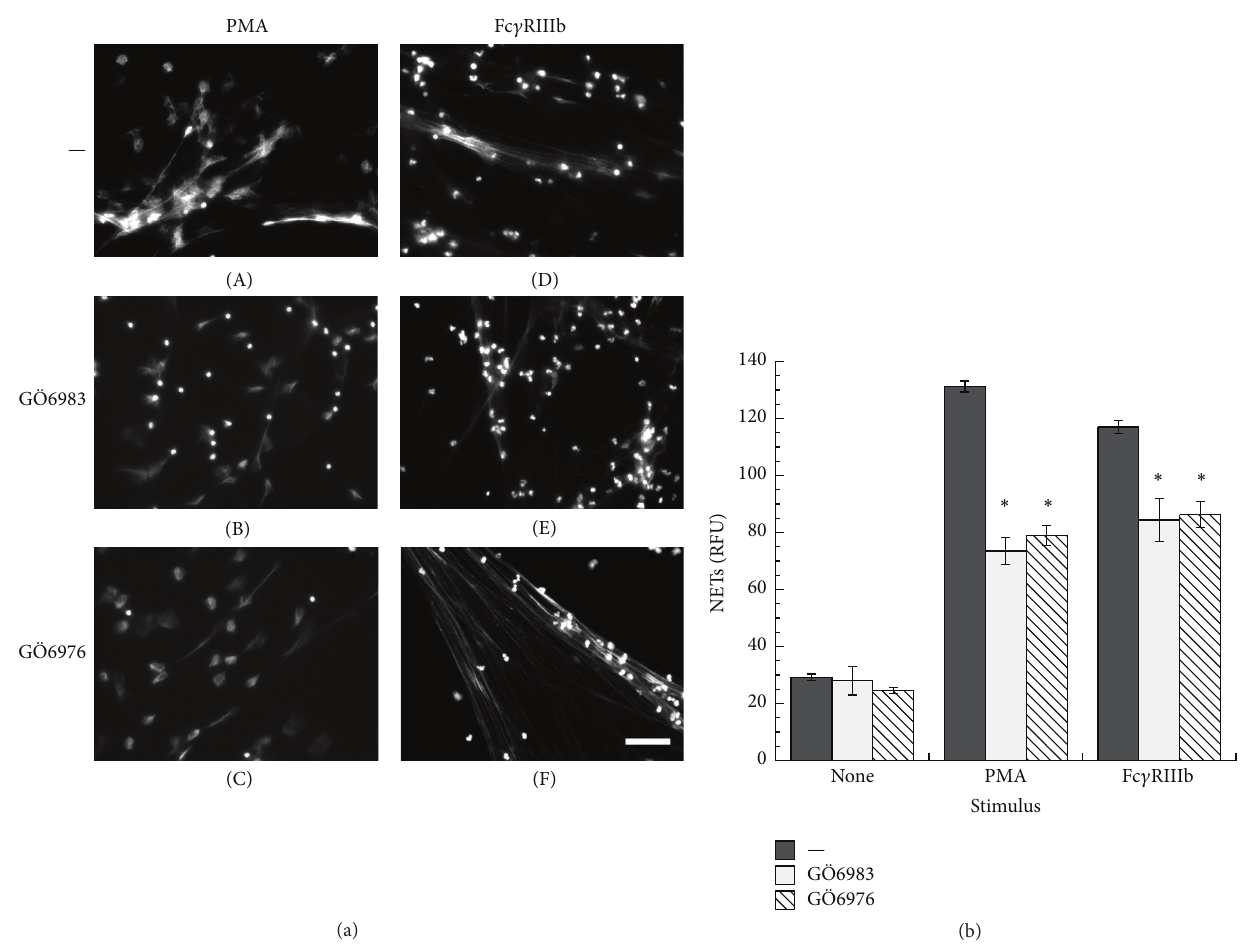
Figure 4: Fc 𝛾 RIIIb-induced NET formation is dependent on PKC. (a) Human neutrophils (PMN) were stimulated with 20 nM phorbol 12- myristate 13-acetate (PMA) or by cross-linking Fc 𝛾 RIIIb with mAb 3G8. PMN were previously treated with solvent alone (—) or with the PKC inhibitors G ¨O6983 (1 𝜇 M) or G ¨O6976 (1 𝜇 M). After four hours, PMN were fixed and stained for DNA (DAPI). Microphotographs were taken at 200x magnification and are representative of five experiments. Bar is 50 𝜇 m. (b) The relative amount of NETs was estimated from SYTOX Green fluorescence in relative fluorescent units (RFU) at 4 hours after stimulation. Data are mean ± SEM of 11 experiments. Asterisks denote conditions that are statistically different from control ( 𝑝 < 0.001